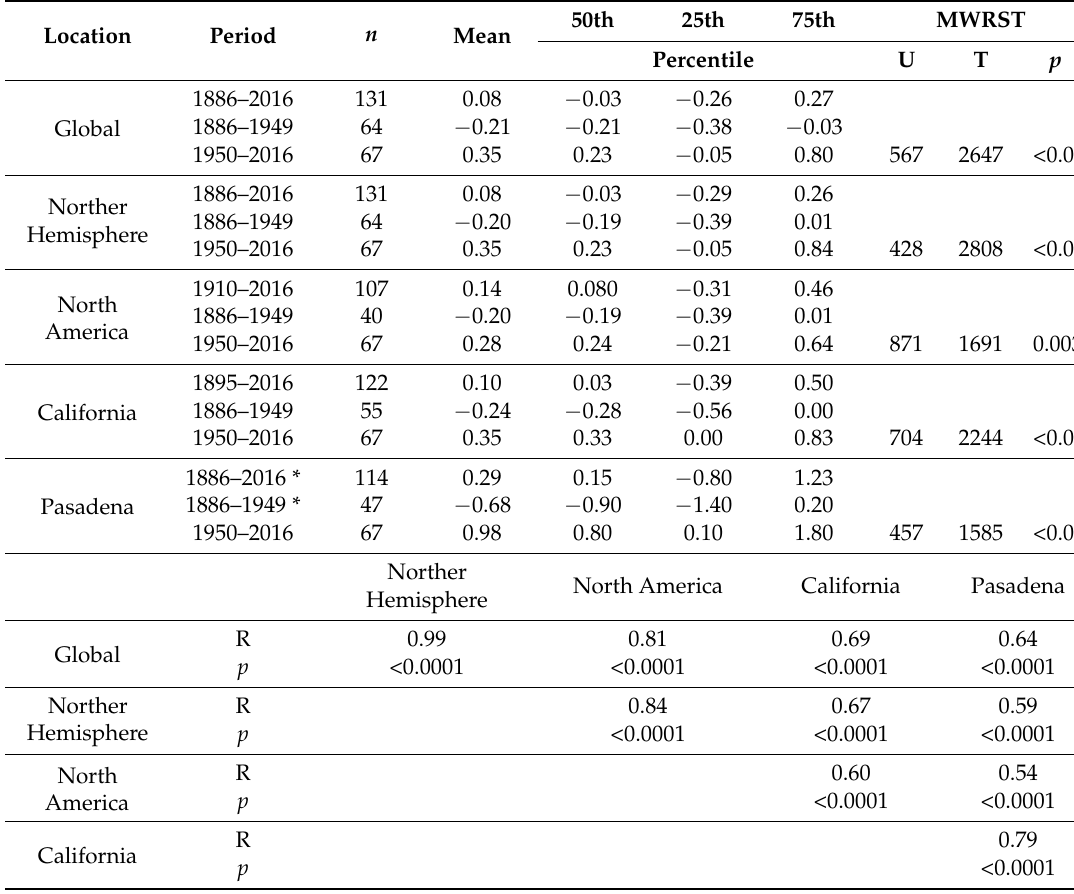
Table 1. Annual average surface temperature deviations from the 1910–2000 average at several locations between 1886–2016 with the Mann-Whitney Rank Sum Test (MWRST) and Spearman Rank Order Correlation. All Results are in Degrees Centigrade